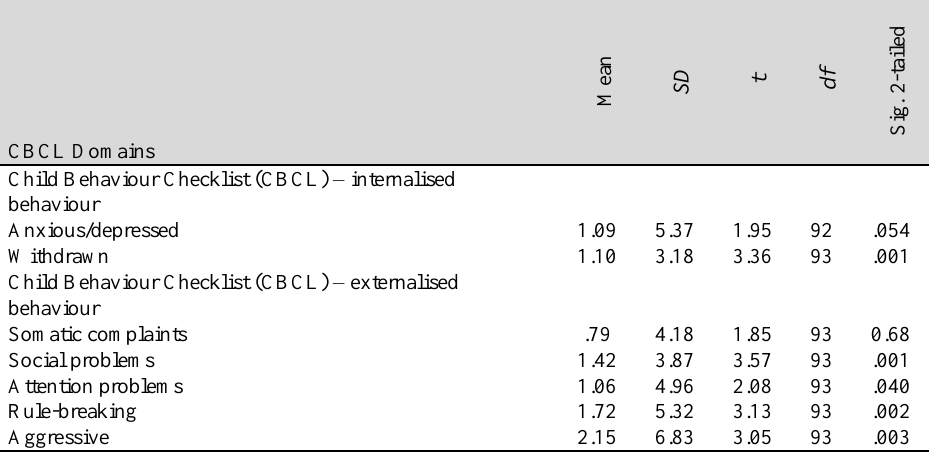
Table 2 Paired Sample t -Test of CBCL domain means between the baseline interview and six-month interview (child behaviour as assessed by the mother participants on the child-focused questionnaires)